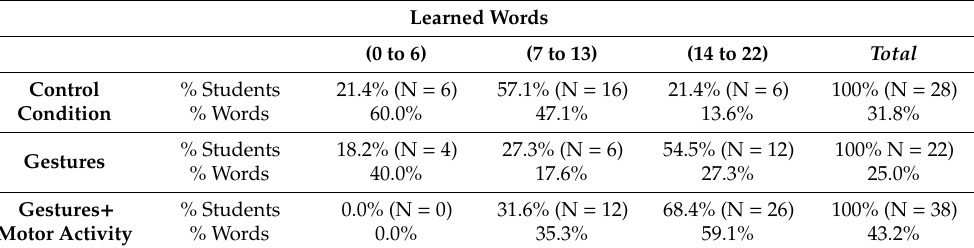
Table 3. Intervention group and number of words assimilated (post-test).